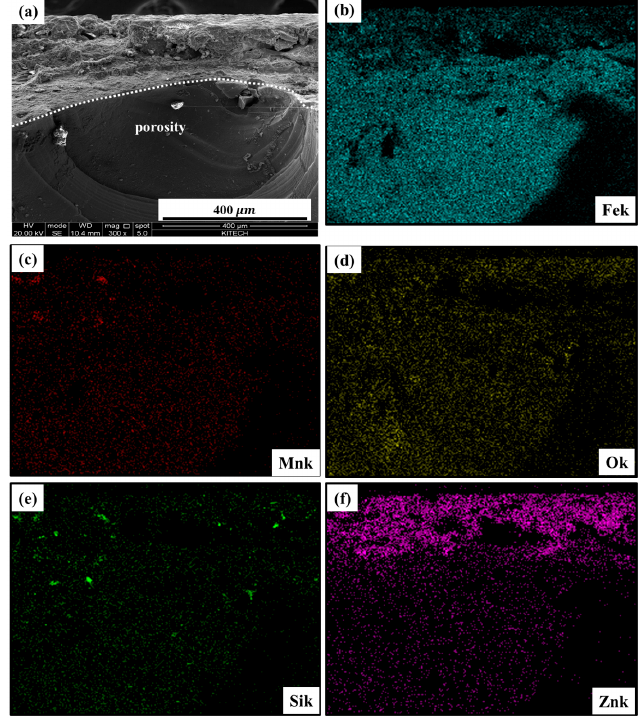
Figure 6. Elemental mapping analysis of porosity cross section of weld: ( a ) 300× image of porous location in the weld; ( b ) FeK, ( c ) MnK, ( d ) OK, ( e ) SiK, and ( f ) ZnK elemental mapping analysis results.